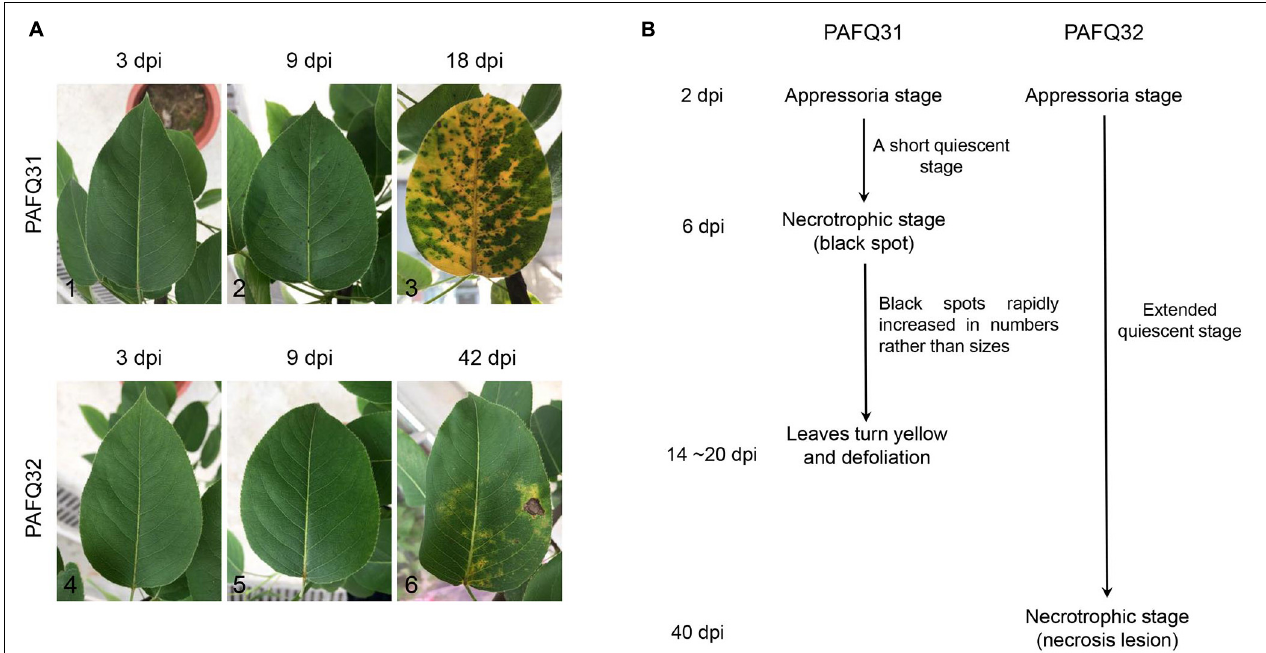
FIGURE 1 | The representative serial symptoms on Pyrus pyrifolia leaves induced by two Colletotrichum fructicola strains under unwounded conditions and the deduced pathogenetic stages. (A) The representative symptoms at 3, 9, and 18 days post-inoculation (dpi) for strain PAFQ31 (A1–A3), and at 3, 9, and 42 dpi for strain PAFQ32 (A4–A6), respectively. (B) The deduced pathogenetic stages for strains PAFQ31 and